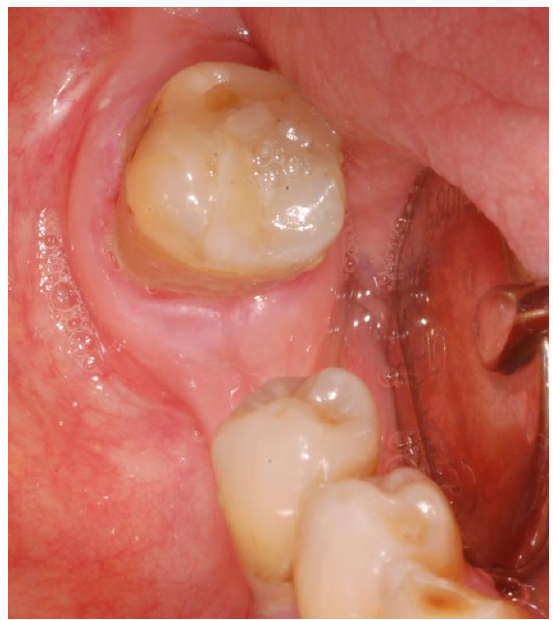
Figure 6. The 3-month postoperative healing on the left side.